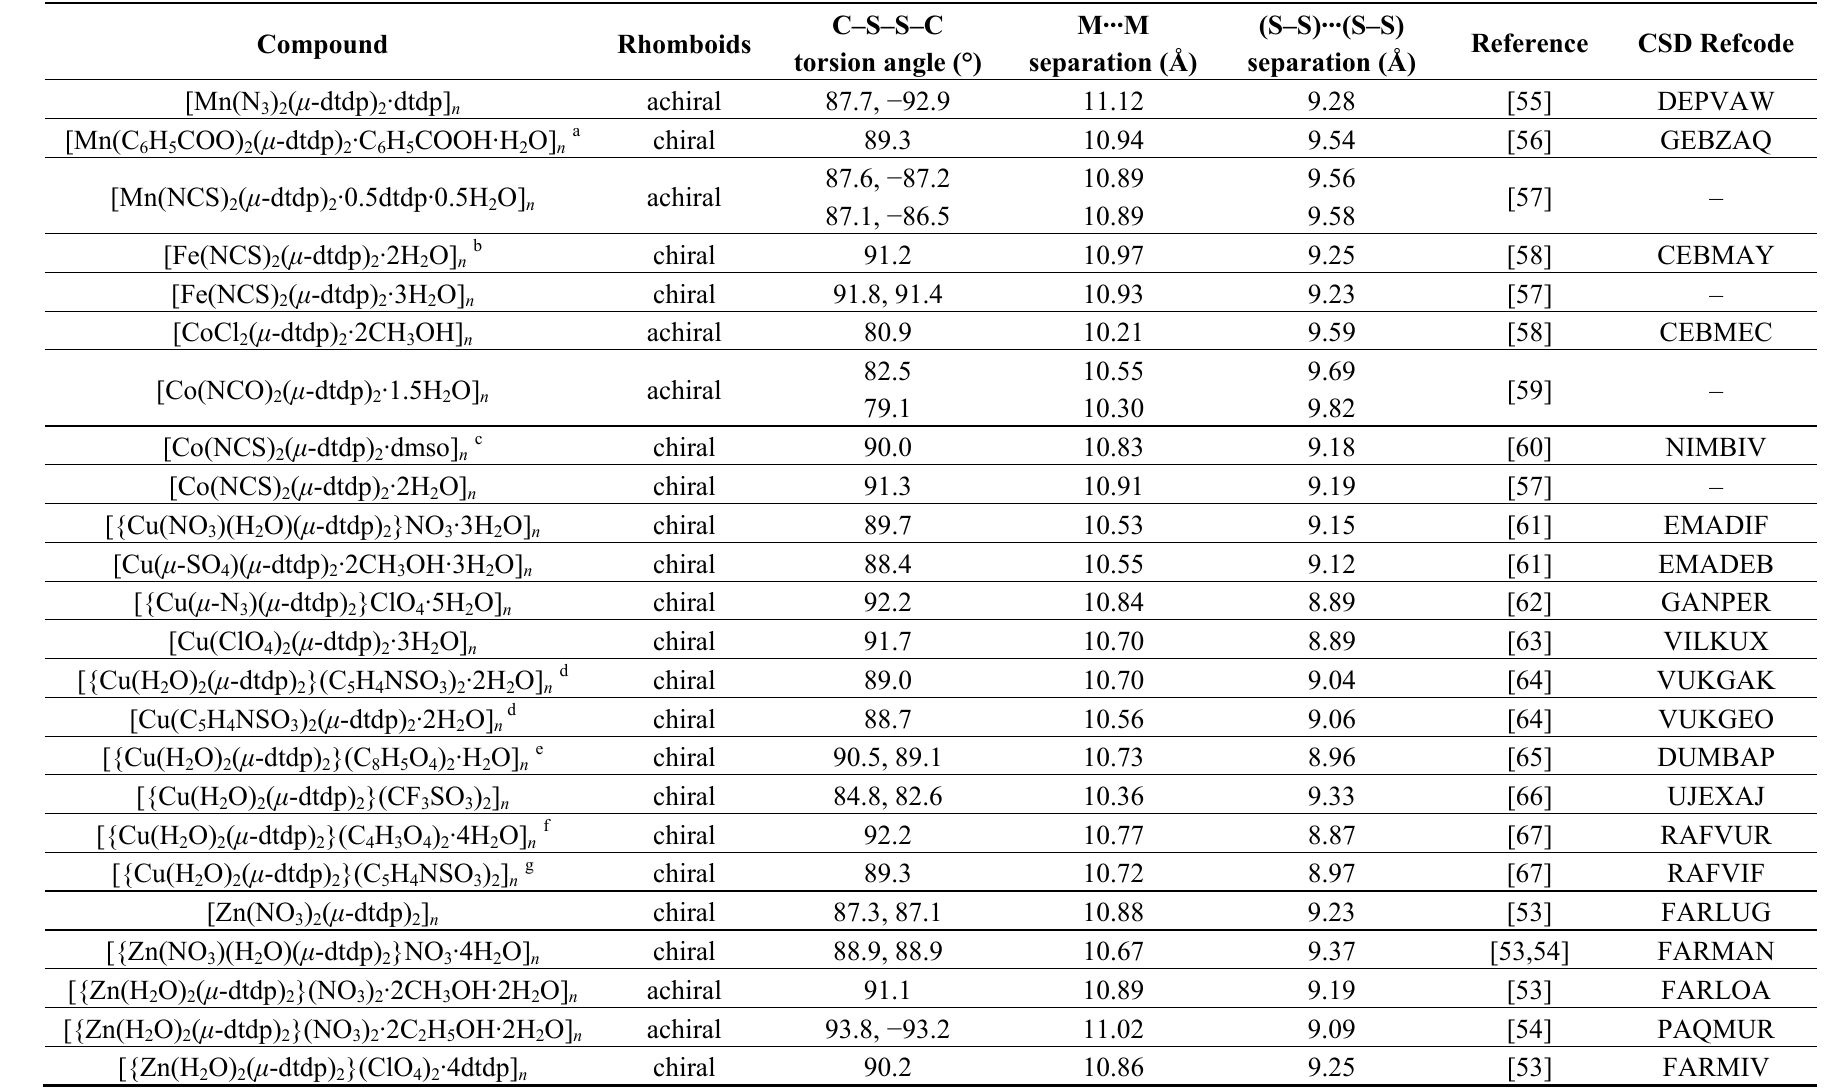
Table 2. Selected structural parameters for repeated